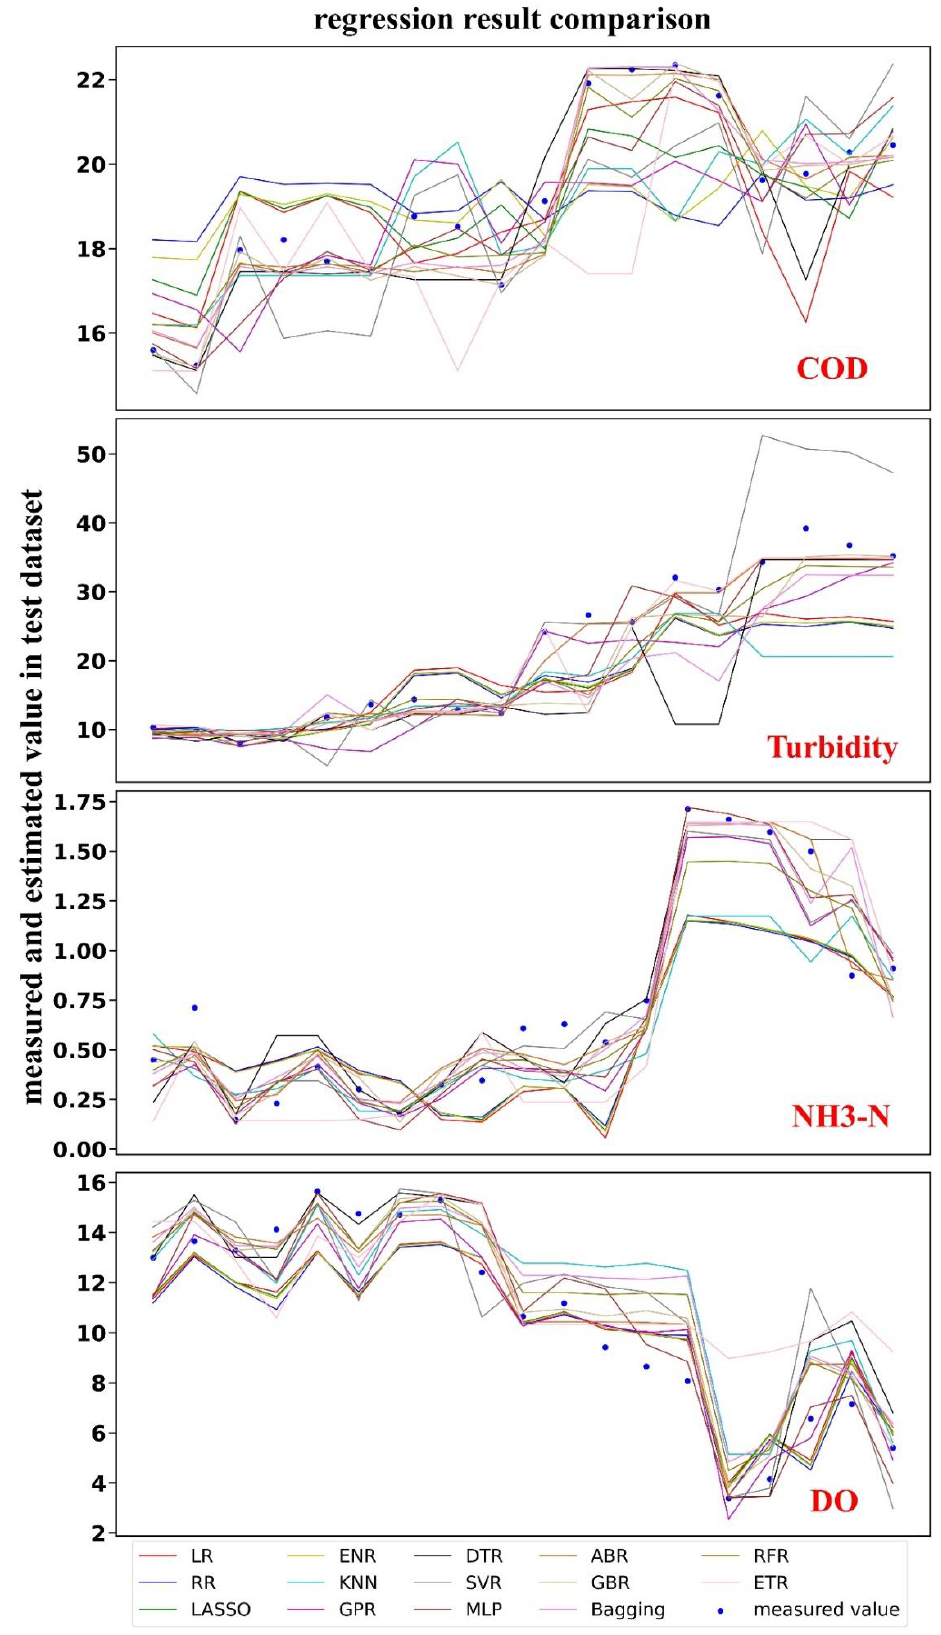
Figure 9. Regression result comparison of COD, turbidity, NH3-N, DO.